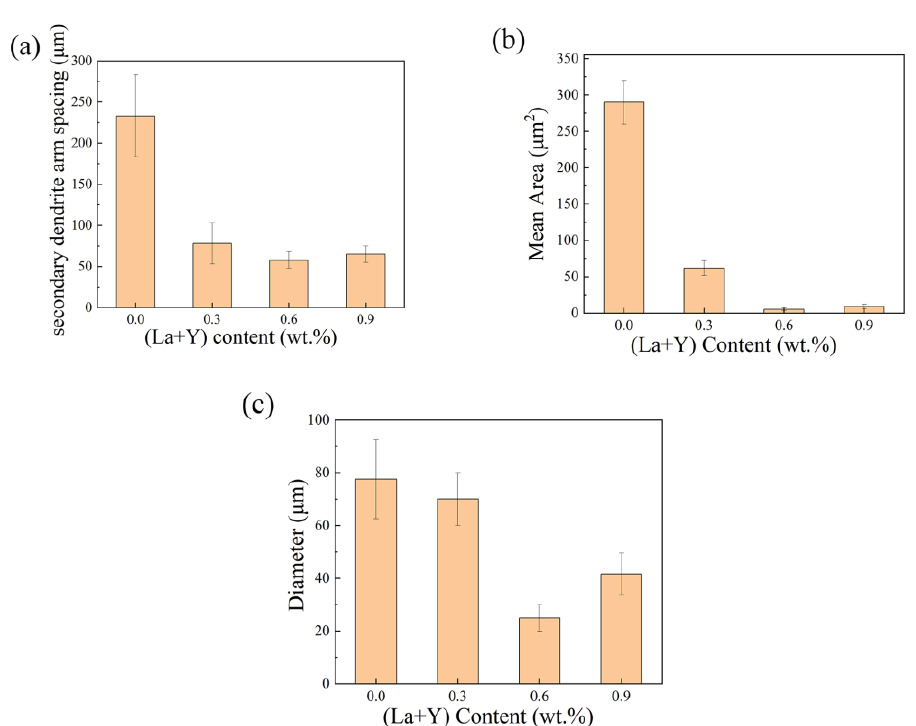
Figure 3. ( a ) The SDAS of α -Al grain, ( b ) the area of eutectic Si, and ( c ) the length of β -Al 5 FeSi phase of A380 alloys with different (La+Y) contents.